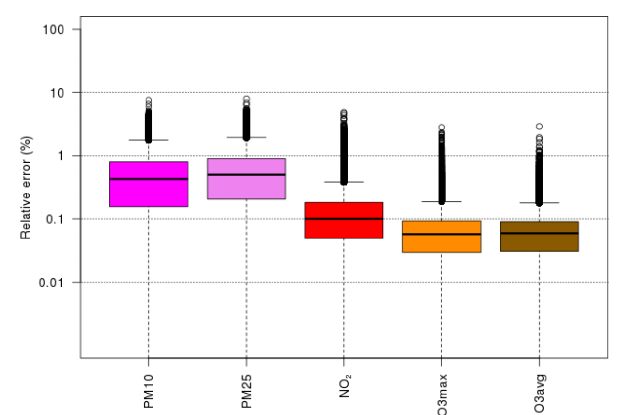
Figure 11. Relative error of the final selected surrogate model for all pollutants. The box plots represent the distribution of relative er- rors over each grid point in western Europe and each day during the relevant air pollution events: wintertime (March 2015, Decem- ber 2016, January 2017) for PM 10 , PM 2 . 5 and NO 2 , summertime (June 2017) for O 3 (i.e. daily maximum ozone) and O 3 max